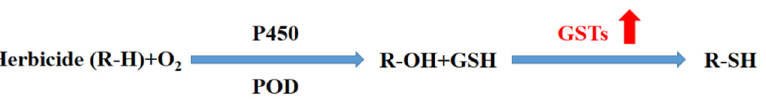
Figure 3. Induction of GSTs to detoxify herbicides (P450: cytochrome P450; POD: peroxidase; GSH: glutathione; GSTs: Glutathione S -transferase).